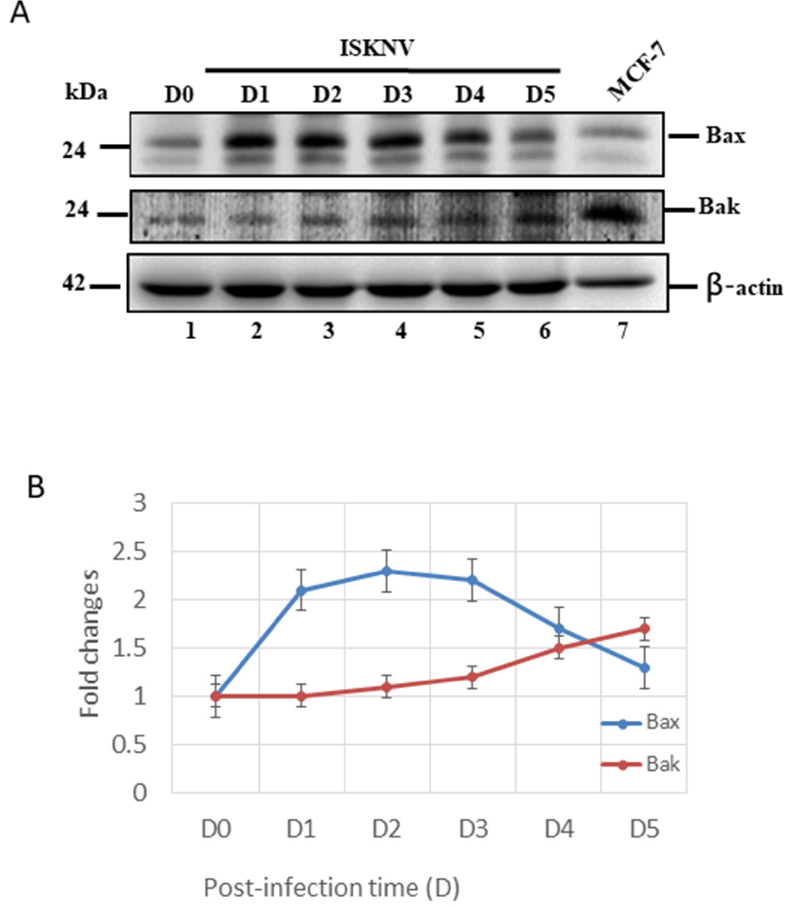
Figure 4. ISKNV infection can upregulate Bax and Bak gene in GF-1 fish cells. ( A ) Identification of Bax and Bak proteins by Western blot analysis. Infection of GF-1 cells with ISKNV at D0, D1, D2, D3, D4, and D5 pt in GF-1 cells, where lanes 1-6 display ISKNV-infected GF-1 cells; and lane 7 shows the control MCF-7 cell lysate. Blots were probed with an anti-mouse Bax and Bak monoclonal antibody (1:7500), and an anti-mouse β -actin monoclonal antibody (1:12,500). ( B ) Quantification of protein expression level by Image J software, from ( A ) that D0 as a one fold control was counted for compared with other ISKNV-infected groups from D1 to D5, respectively.